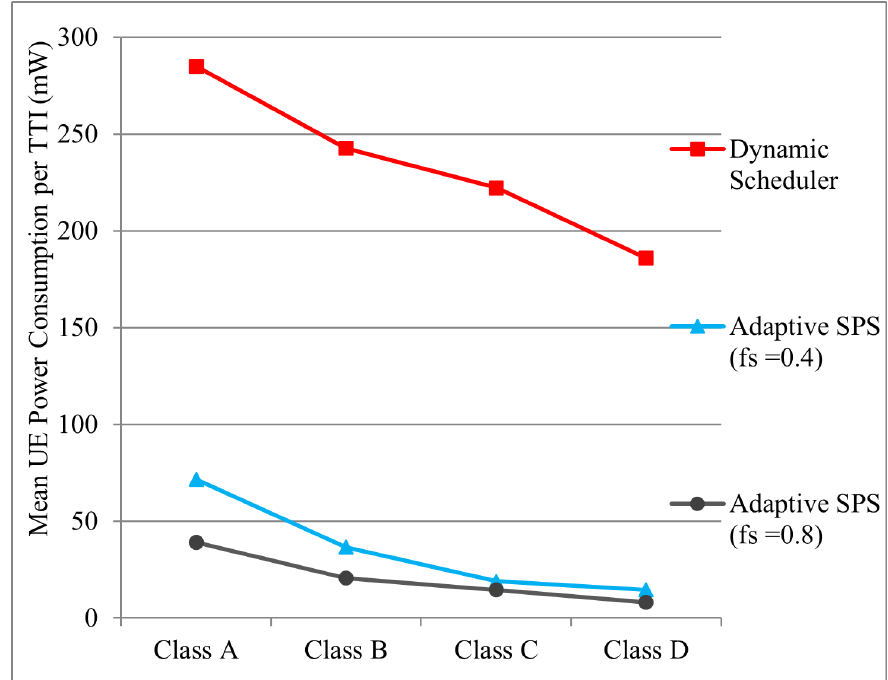
Figure 20. Average UE power consumption in mW per TTI.